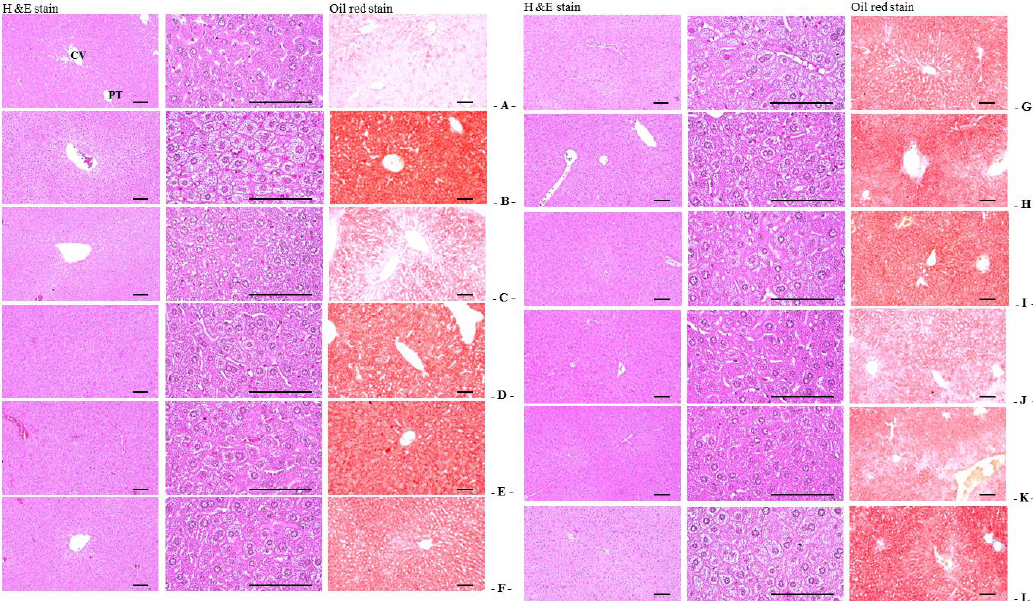
Figure 4. Representative histological images of the left lateral lobes of liver, taken from sham-operated